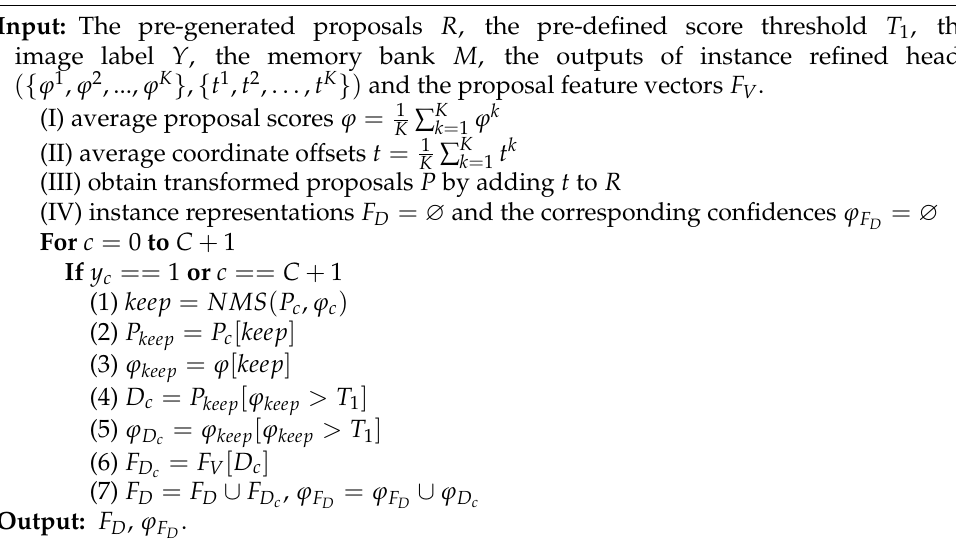
Algorithm 1 Instance representation mining